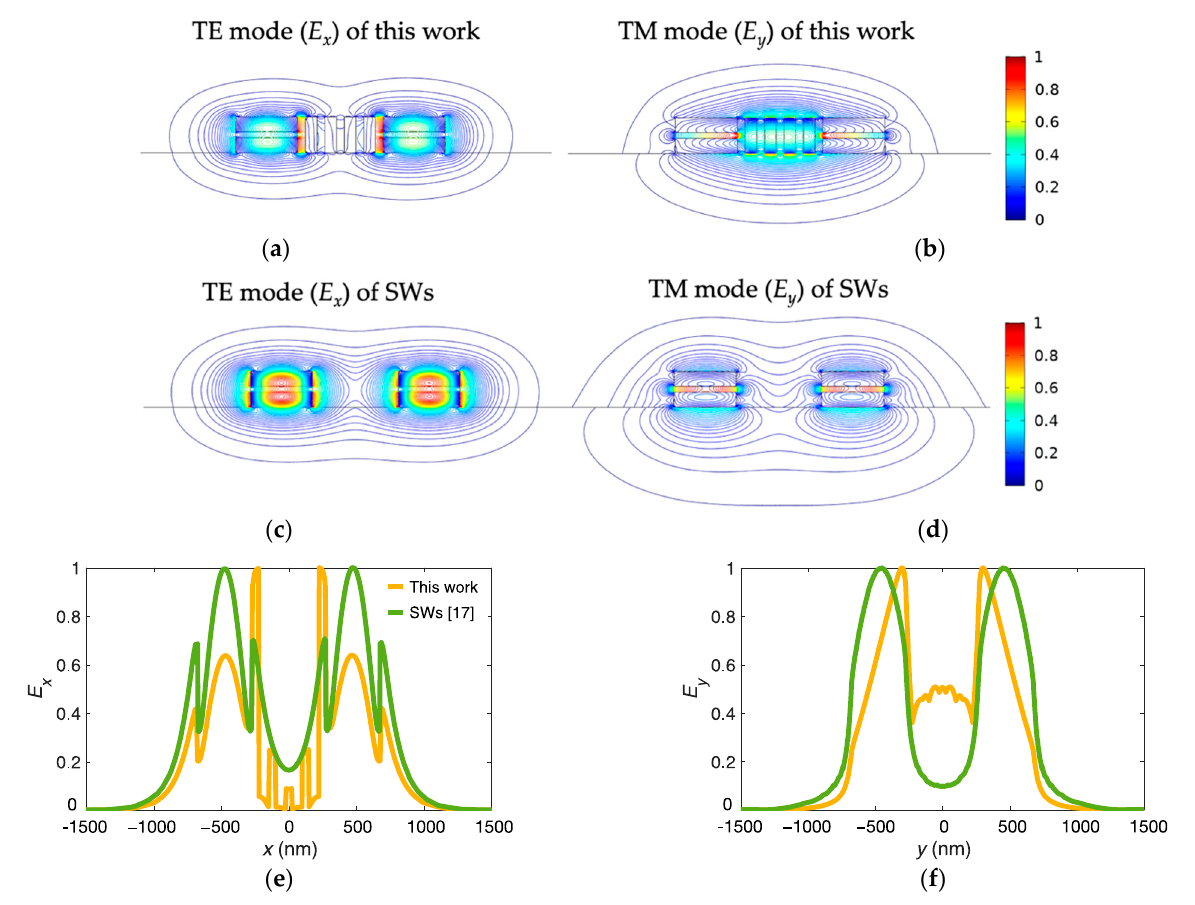
Figure 4. Field contours of the even modes of ( a ) TE and ( b ) TM and those of ( c ) TE and ( d ) TM of the SWs for W Si = 400 nm, t s = 60 nm, h Si = 150 nm, W Cl = 75 nm, g = 50 nm, s = 550 nm, and λ = 1550 nm. ( e ) Field amplitudes at the central lines of the slot along the x directions of ( a ) and ( c ); ( f ) field amplitudes at the central lines of the slot along the x directions of ( b ) and ( d ).